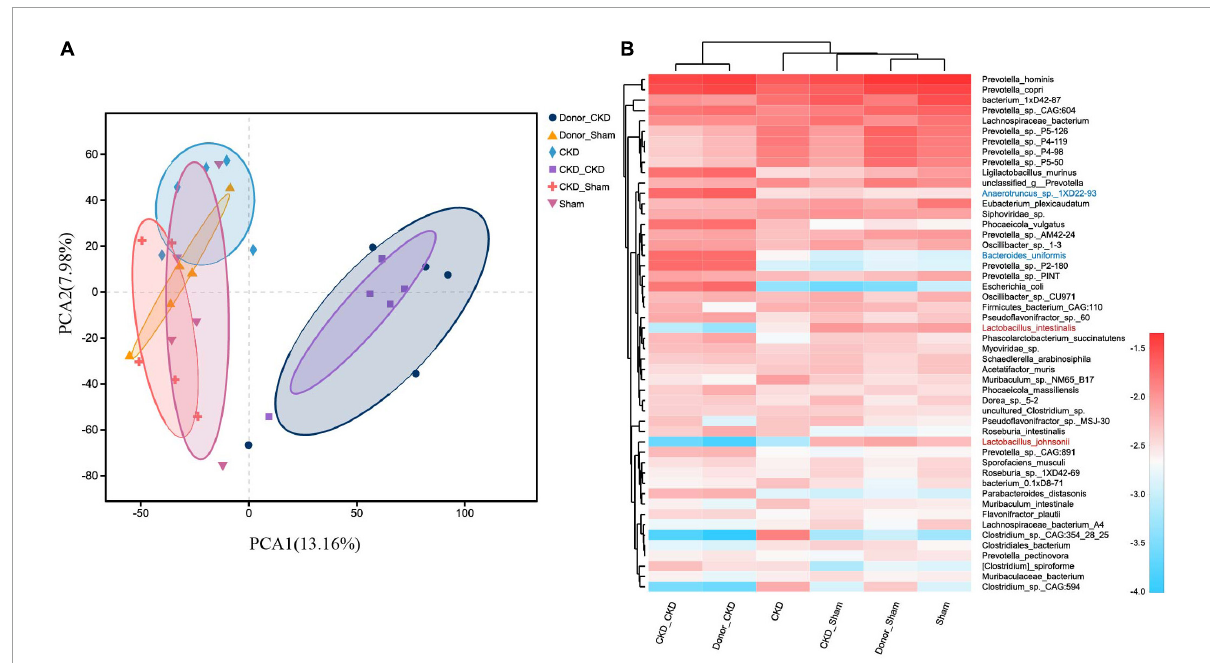
FIGURE5 MGS changes after successful FMT. (A) PCA plots of species-level metagenomic expression (PERMANOVA p < 0.05). (B) Heat map of hierarchical clustering analysis of the differentially expressed species. The sample name and species name are shown on the lower and right side of the heat map, respectively, and the species clustering tree and sample clustering tree are shown on the left and upper side if cluster analysis was performed, respectively. The scale of the heat map means